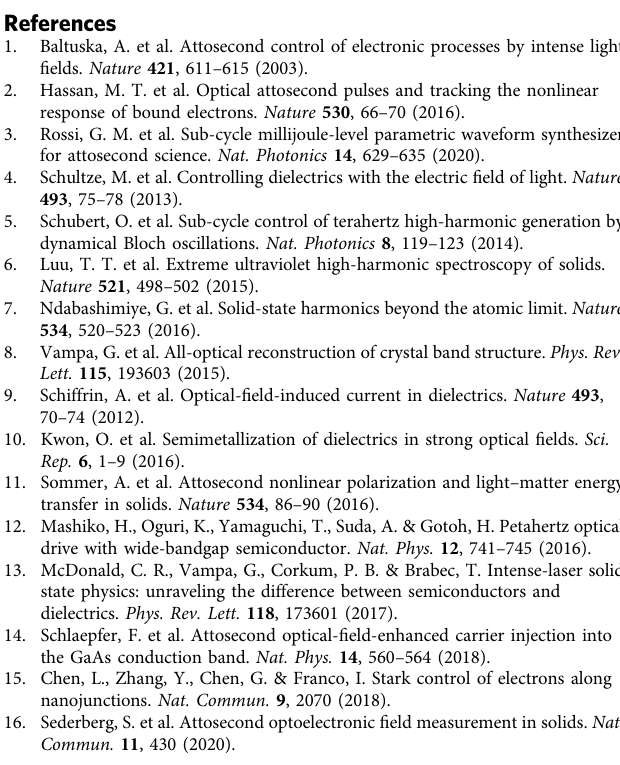
Fig. 4 in the main text. As in the experiment, we fi nd a linear mapping between vector potential and resulting LPPS signal at all intensities for neon, where electrons experience a perfectly parabolic single-band free-electron dispersion relation in the ionization continuum and coupling to higher bands does not exist. LPPS with a chirped VUV source pulse . In the simulations, the timing and ef fi ciency of the interband transitions can be further investigated by considering chirped source pulses. Translating the high-frequency spectral portion under the envelope of the VUV pulse injects carriers at k -values closer to the avoided crossings, thus the largest deviation Δ S ( τ ) appears earlier within the optical half- cycle preceding the gate fi eld maximum. Supplementary Fig. 2 explores this effect for high fi eld intensities and large source pulse chirp (0.27 fs 2 ) to highlight this behavior. We consider this mechanism as the source of the small time-advance of the maximal deviation observed in the experiment versus the